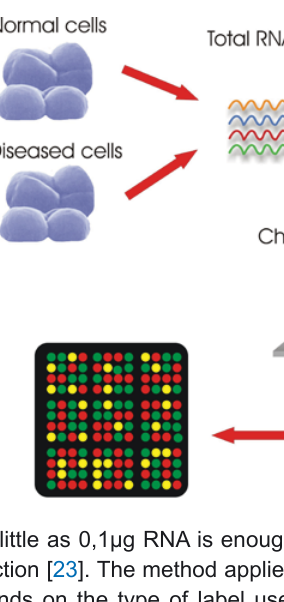
Figure 4. Comparative genomics hibridization